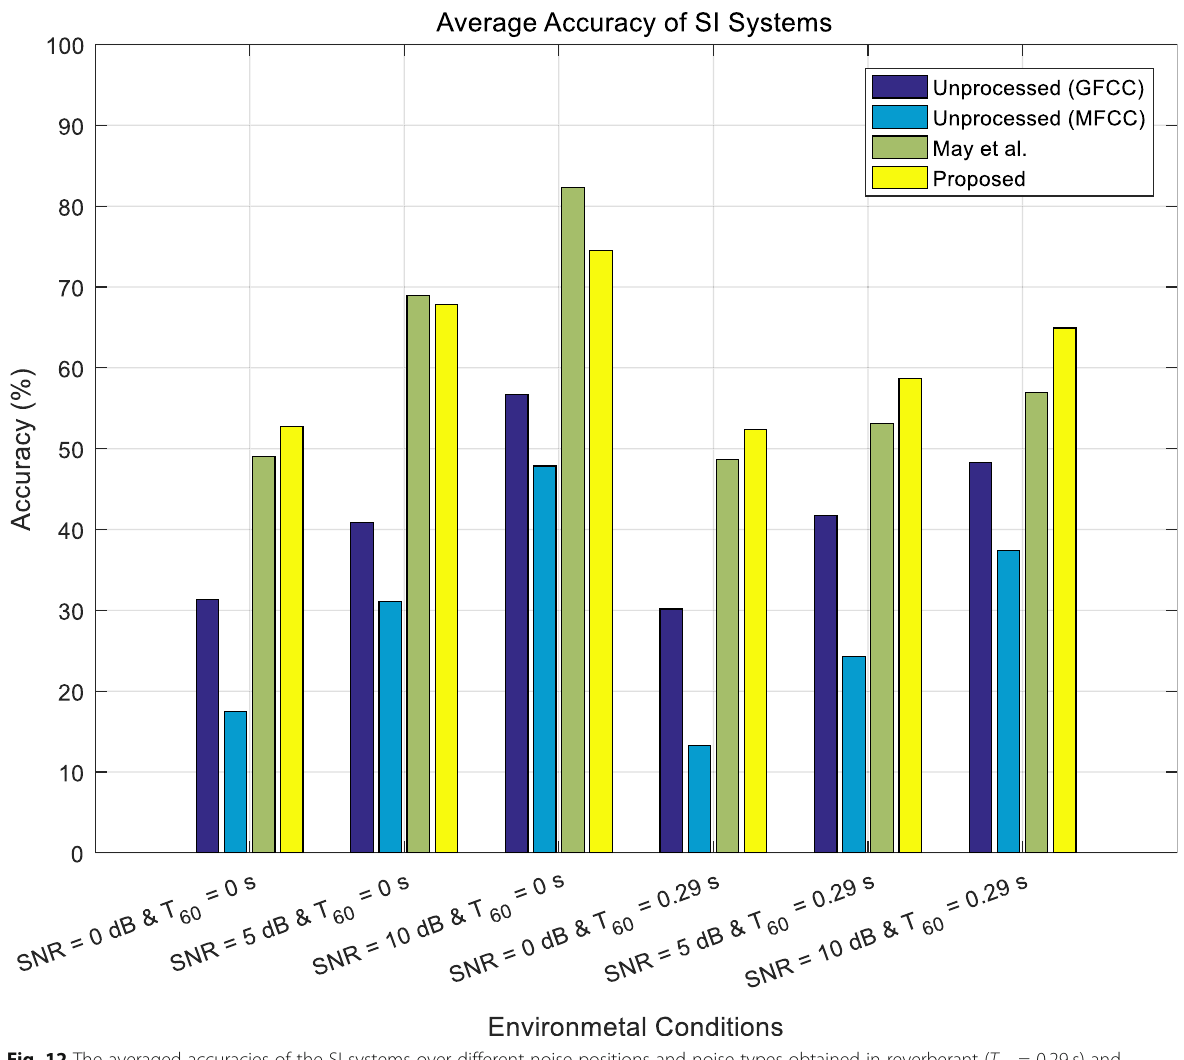
Fig. 12 The averaged accuracies of the SI systems over different noise positions and noise types obtained in reverberant ( T 60 = 0.29 s) and additive noise conditions (SNRs = 0, 5, 10